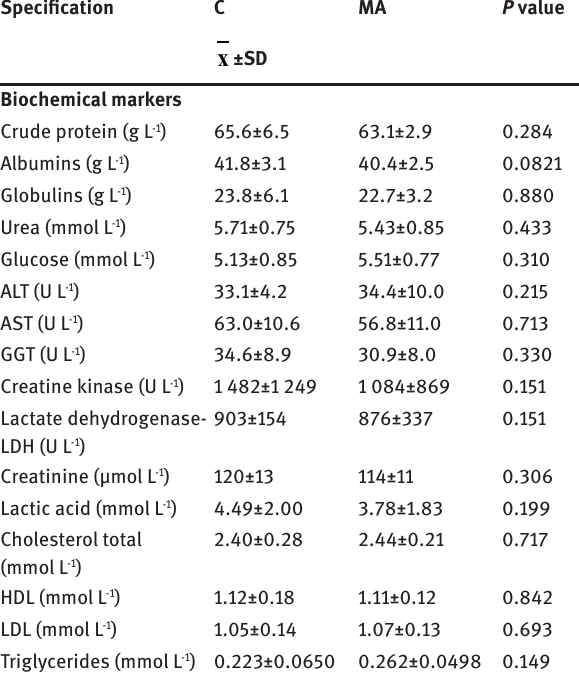
Table 7: The concentration of biochemical markers in the serum of growing pigs .